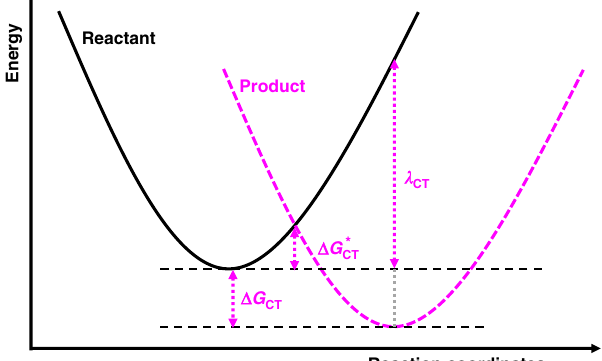
Fig. 5 Schematic representation of charge transfer. Energy parabola shift along the energy axis and the reaction coordinates showing the Gibbs free gain ( Δ G CT , driving force), the activation energy Δ G (cid:1) reorganization energy ( λ CT